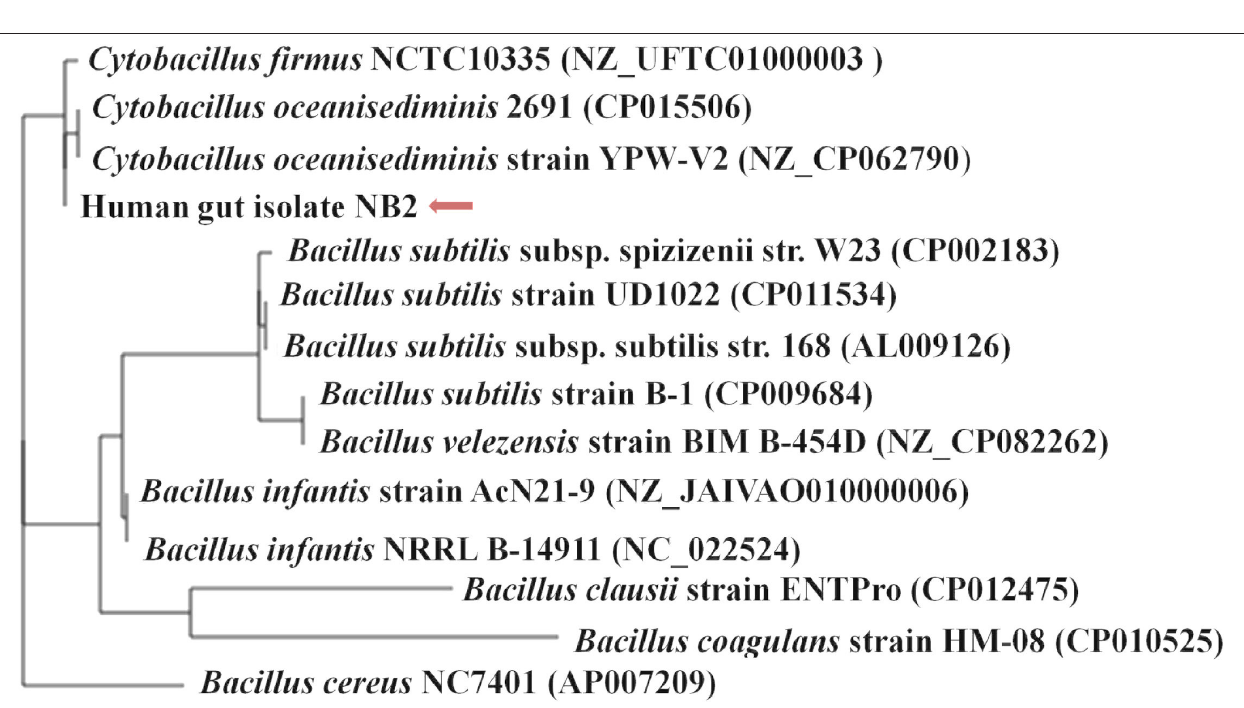
FIGURE 4 | Phylogenetic assessment of the genome of Cytobacillus oceanisediminis NB2 with the genomes of other Bacillus species. The phylogenetic relationship of the gut bacterial isolate strain NB2 was assessed with other Bacillus genomes using M1CR0B1AL1Z3R webserver (https://microbializer.tau.ac.il/). The online tool extracts ORFs, detects OGs, extracts OG sequences, infers a core proteome, and reconstructs the species’ phylogeny. The tree was drawn by taking Maximal e-value cutoff: 0.01; identity minimal percent cutoff: 80.0%; minimal percentage for core: 100.0% with no bootsrapping.